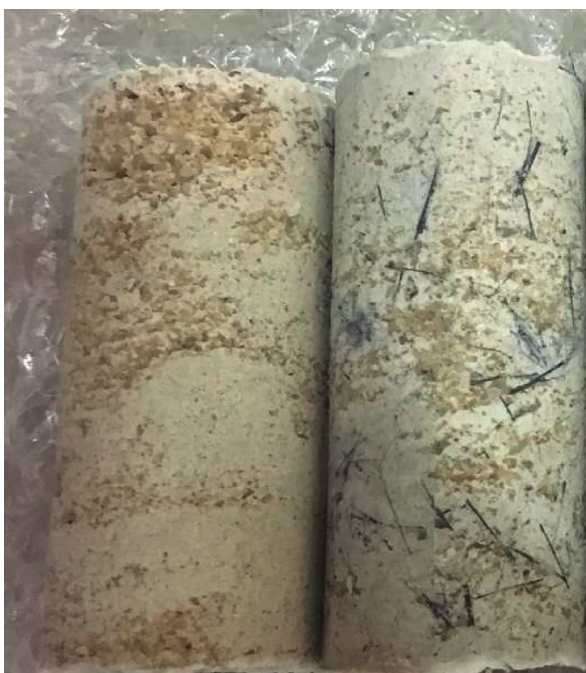
Figure 4: Microbial solidified sample of silica sand in private mold.